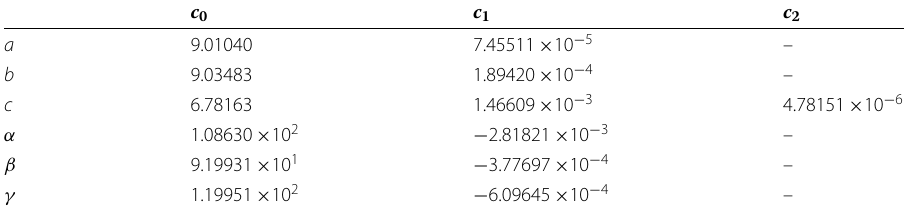
Table 3 Polynomial fitting coefficients of the form c 0 + c 1 T + c 2 T 2 , where T is temperature, for single crystal TATB lattice parameter variation fit to the measurements of [31]